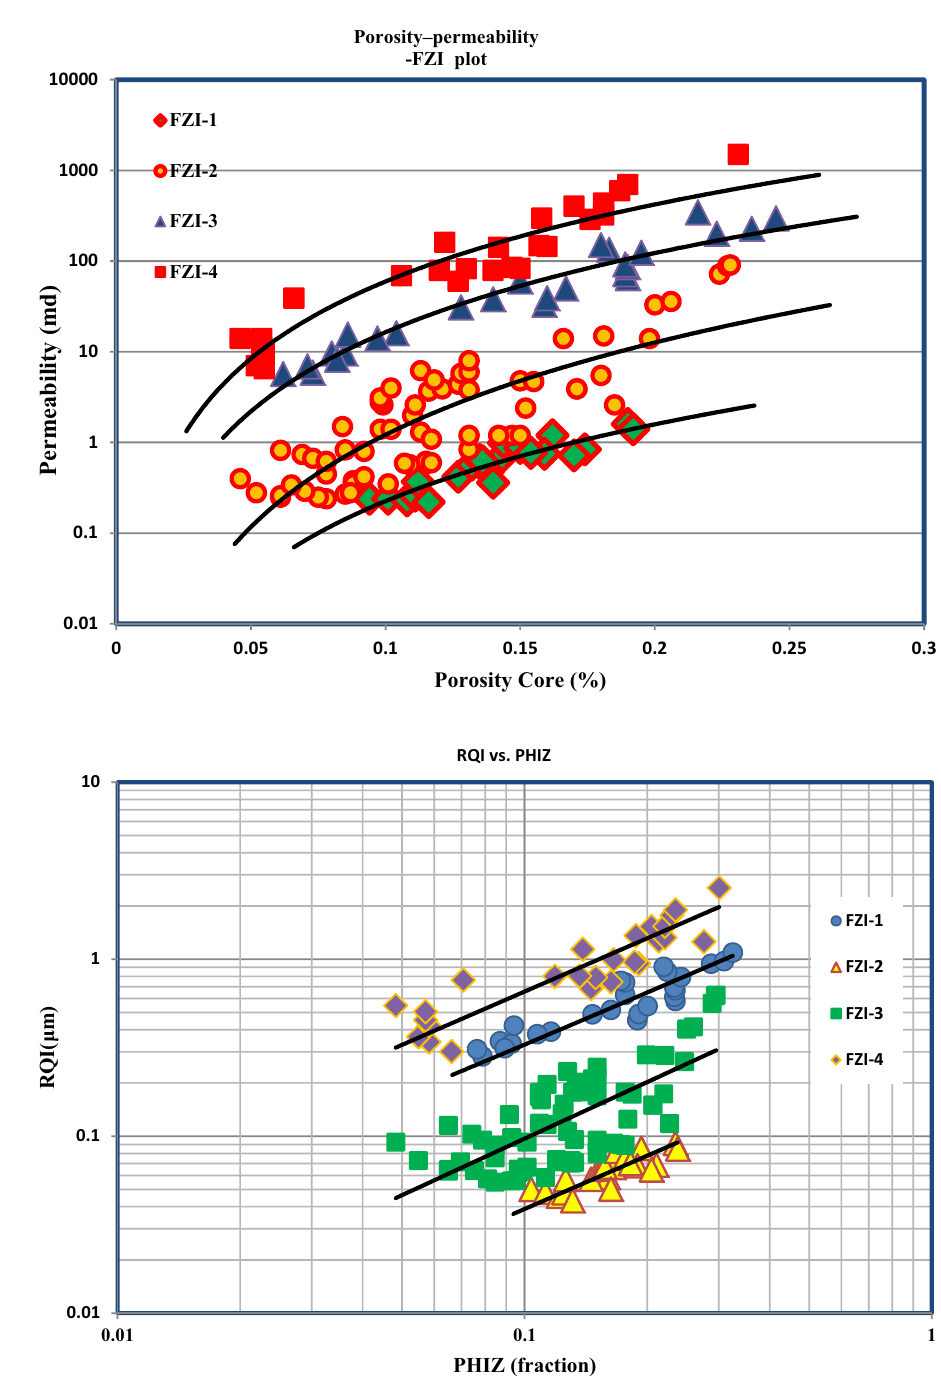
Pore-throat size (R35) determining depending on the core Permeability and Porosity in reservoir units provides best basis for defining reservoir flow units (Al-Jawad et al. 2014). R35 values are utilized to define petrophysical units as fol- lows (Martin et al. 1997): Mega port; units with R35 values greater than 10 μ. Macro port; units with R35 values between 2 and 10 μ. 1 3